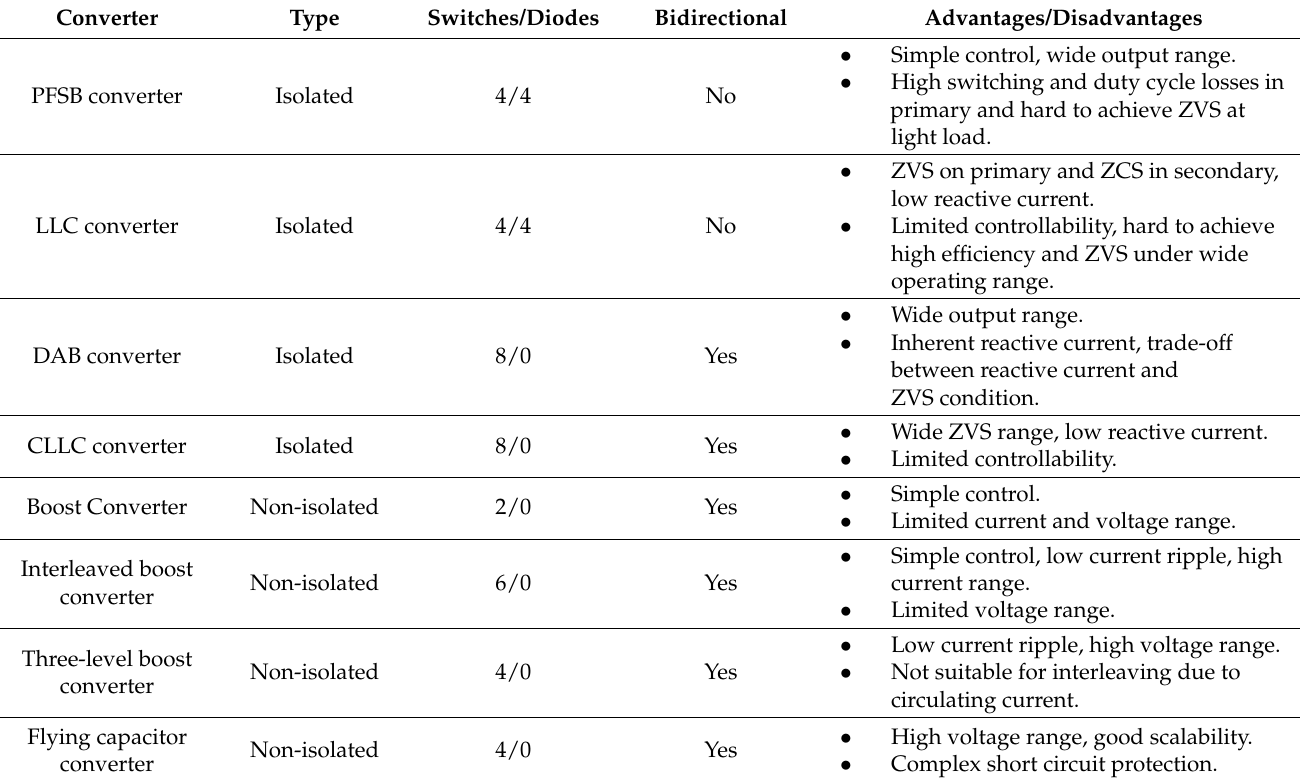
Table 2. Comparison of various isolated and non-isolated DC/DC converter topologies for DCFCs (Reprinted with permission from Ref. [6]. Copyright 2019